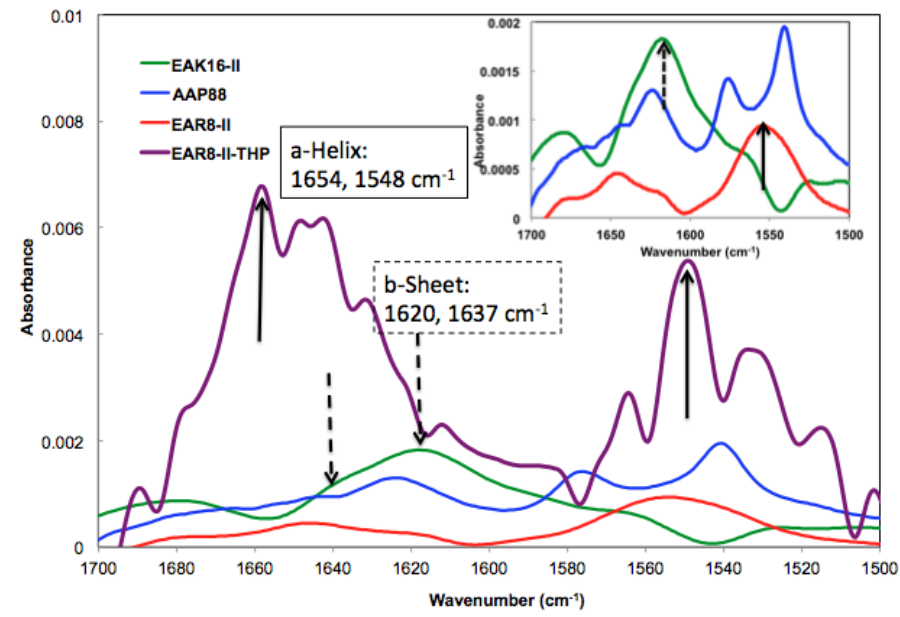
Figure 3. Absorbance spectrum of ( – ) EAK16-II; ( – ) AAP8; ( – ) EAR8-II; and ( – ) EAR8-II-THP complex collected by FT-IR indicating secondary